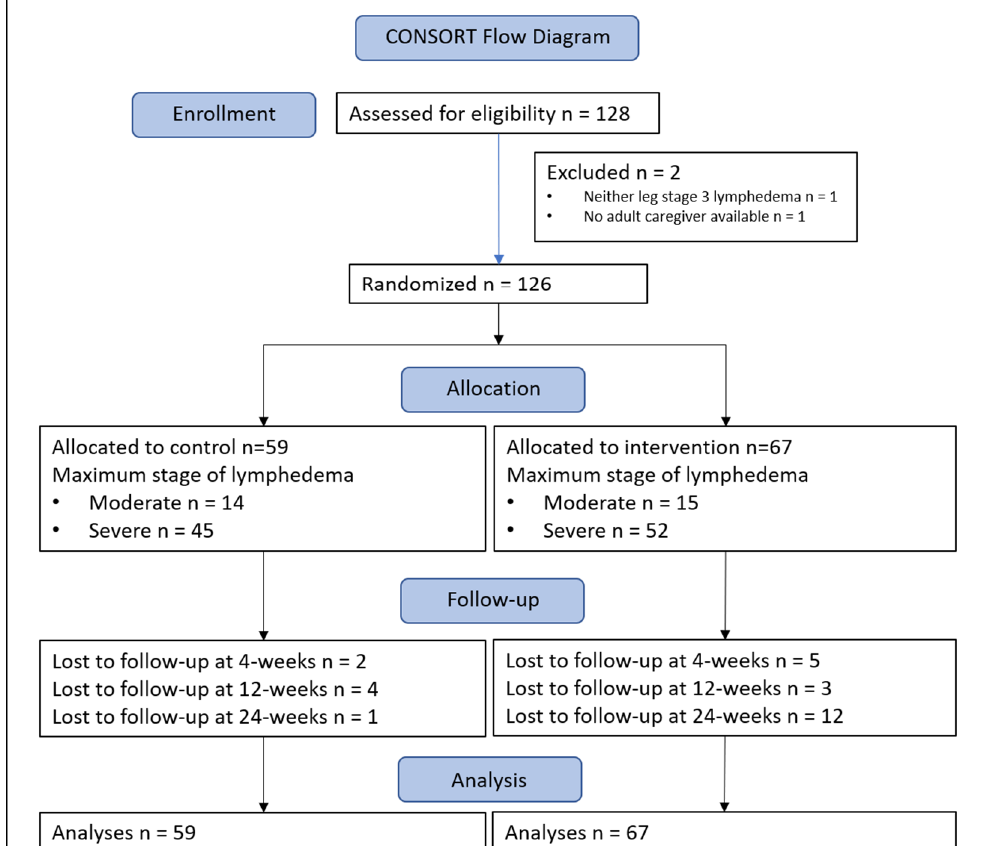
Supplementary Table S1. J. Clin. Med. 2020 , 9 , x FOR PEER REVIEW